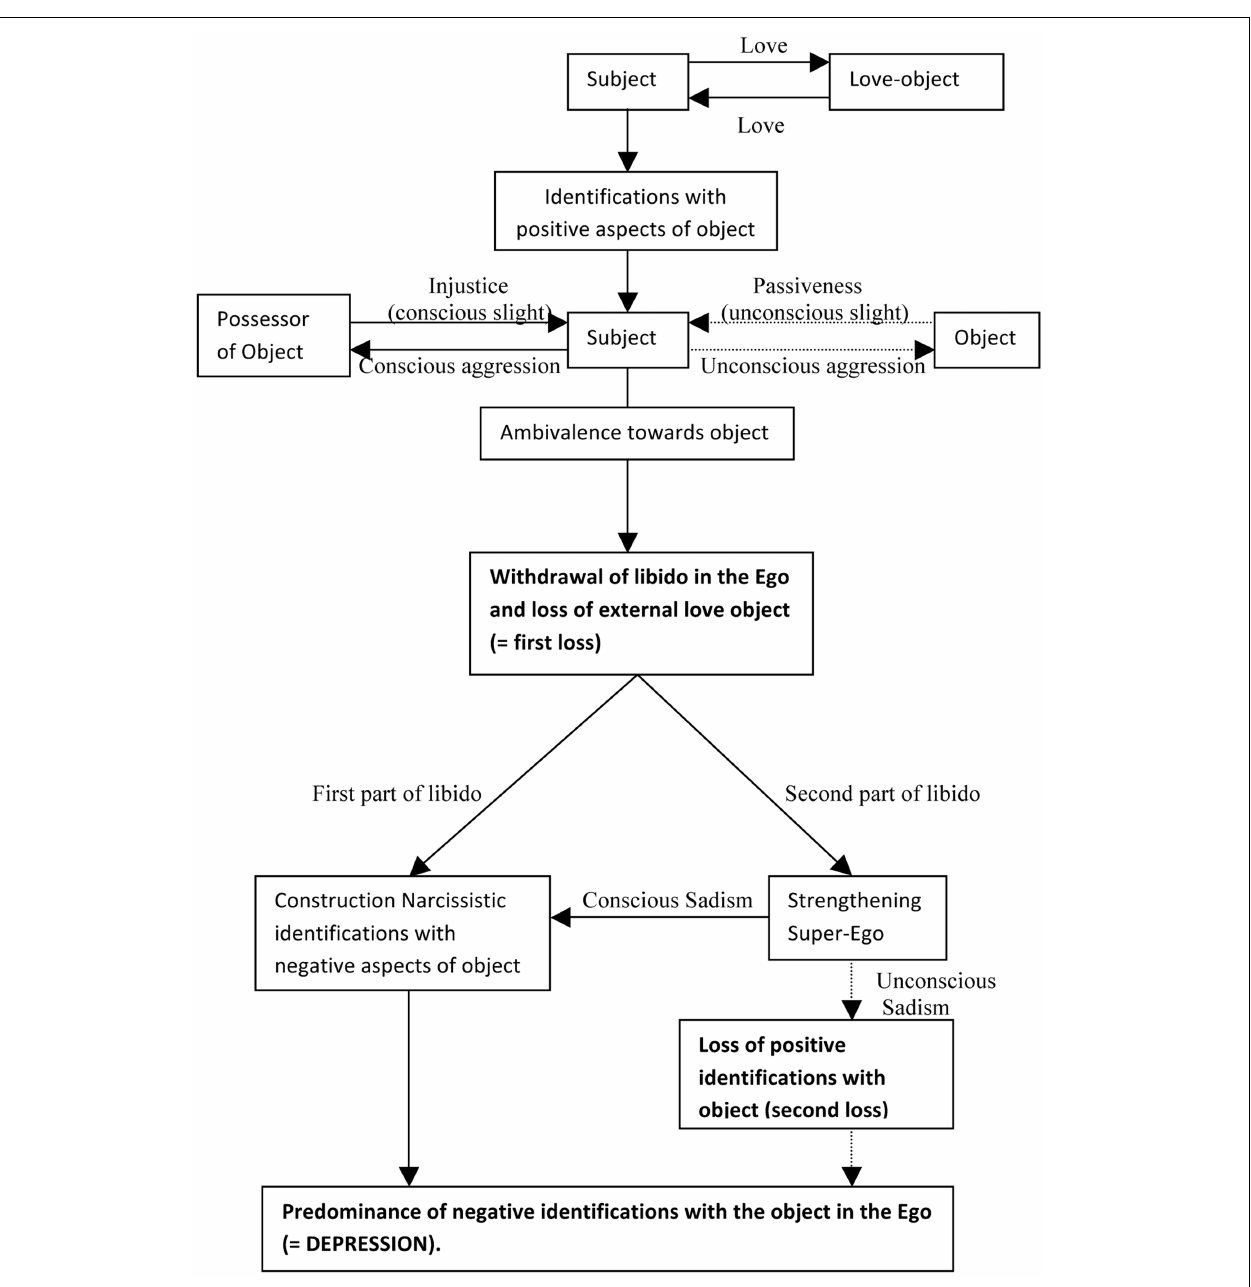
FIGURE 2 |The intra- and interpersonal loss in the etiology of depression differentiating between identifications with positive and negative aspects of the